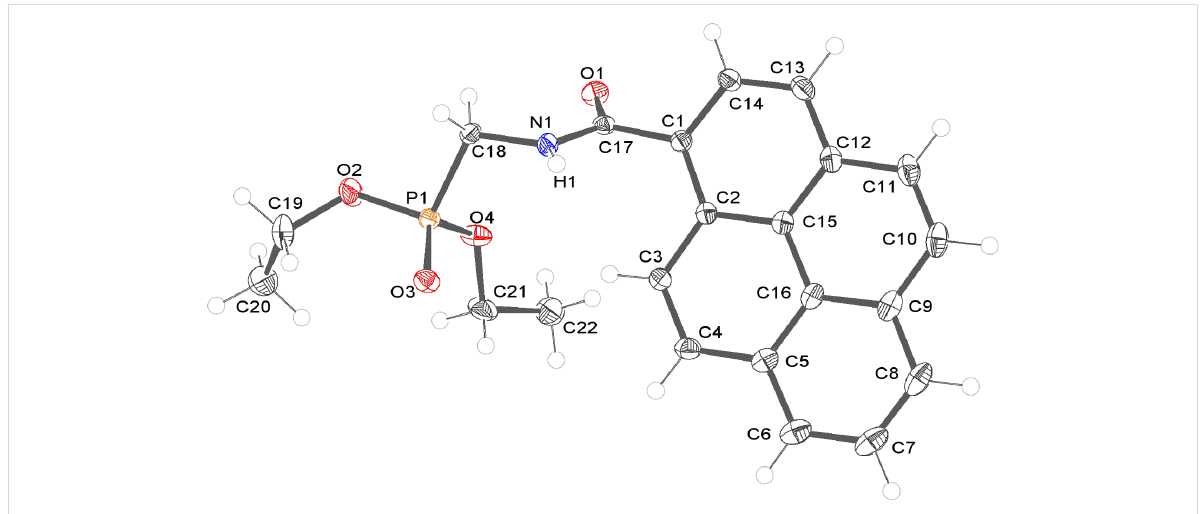
Figure 6: Molecular structure of 3a (ORTEP representation). Displacement ellipsoids were drawn at a 50% probability level. Hydrogen atom labels are analogous to those of bonded non-H atoms and were omitted for clarity, apart from the H1 atom which was involved in intermolecular hydrogen bond formation.